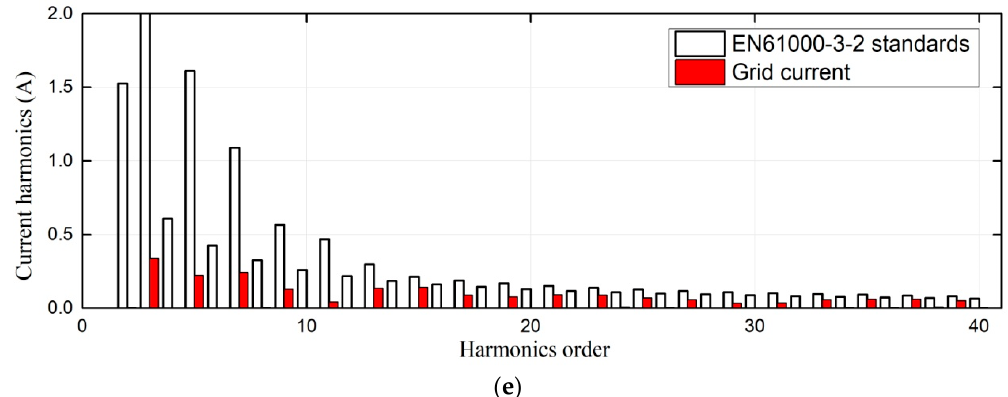
Figure 23. Simulation result of the proposed control method under observer parameter variation: ( a ) Motor Speed; ( b ) Position and estimated error; ( c ) DC-link voltage and grid current; ( d ) Motor output torque; ( e ) FFT analysis of grid current.